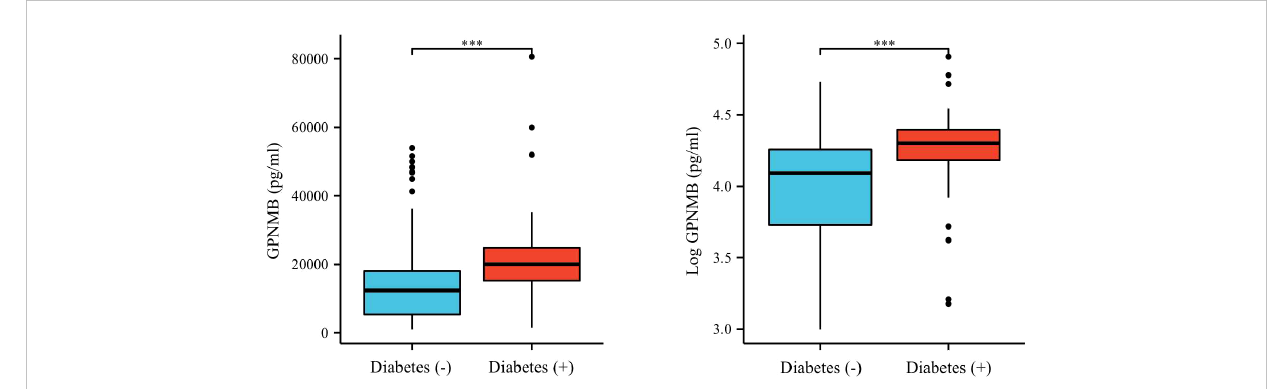
FIGURE 1 Plasma GPNMB levels depending on the existence of diabetes. ***P < 0.001 using a Wilcoxon rank sum